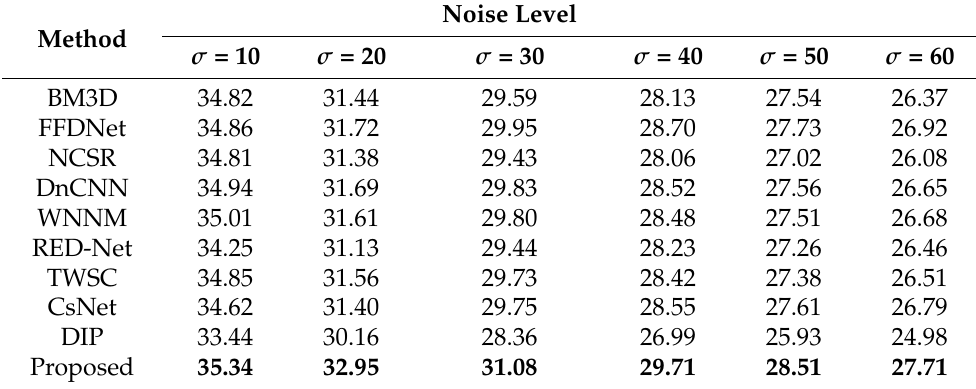
Table 6. Average PSNR results of different methods on 10 commonly used images with various noise levels.